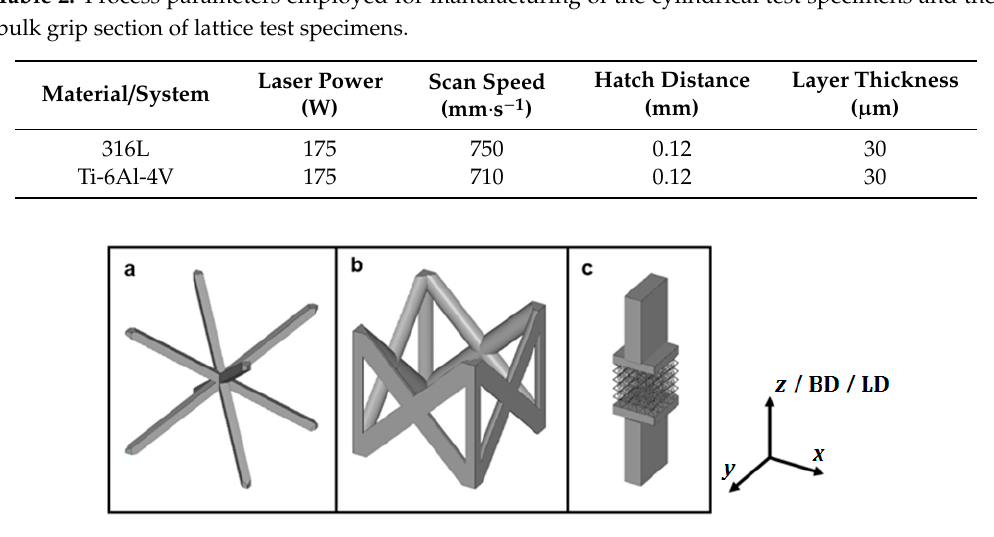
Figure 3. Base cells of the lattice structures, ( a ) bcc; ( b ) f2ccz; ( c ) bcc specimen geometry, recompiled from [35].